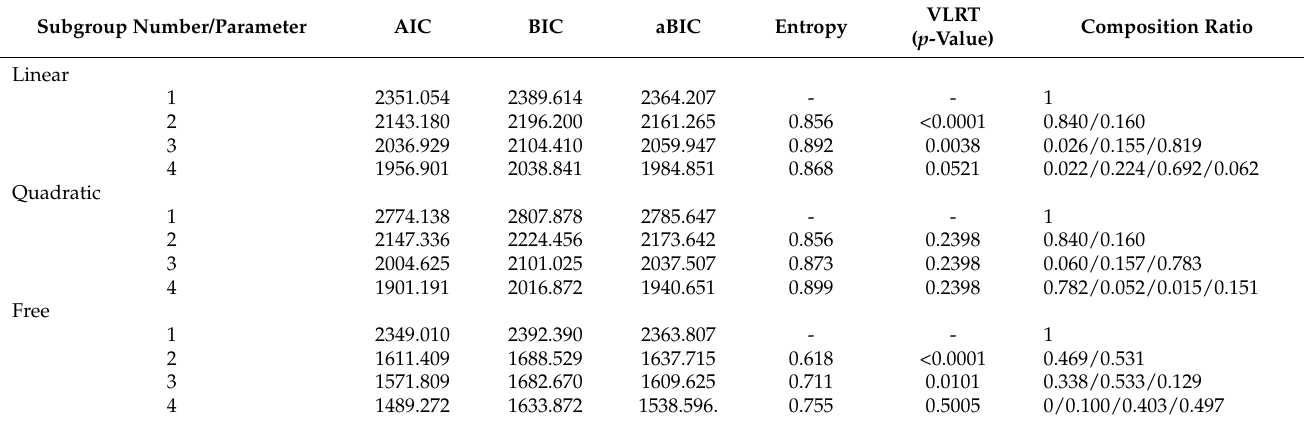
Table A1. GMM fitting statistics results (prenatal stress).